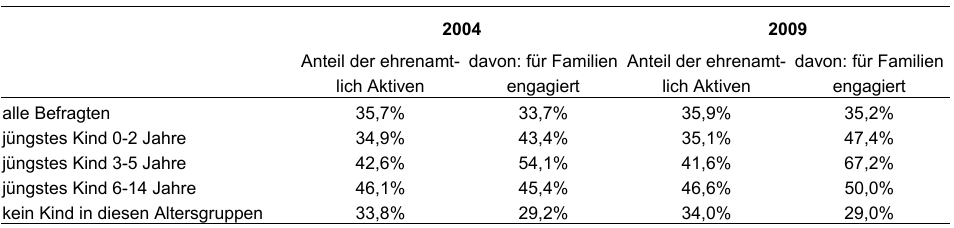
Tabelle 2: Bürgerschaftliches Engagement und familienbezogenes Engagement in Abhängigkeit vom Alter des jüngsten